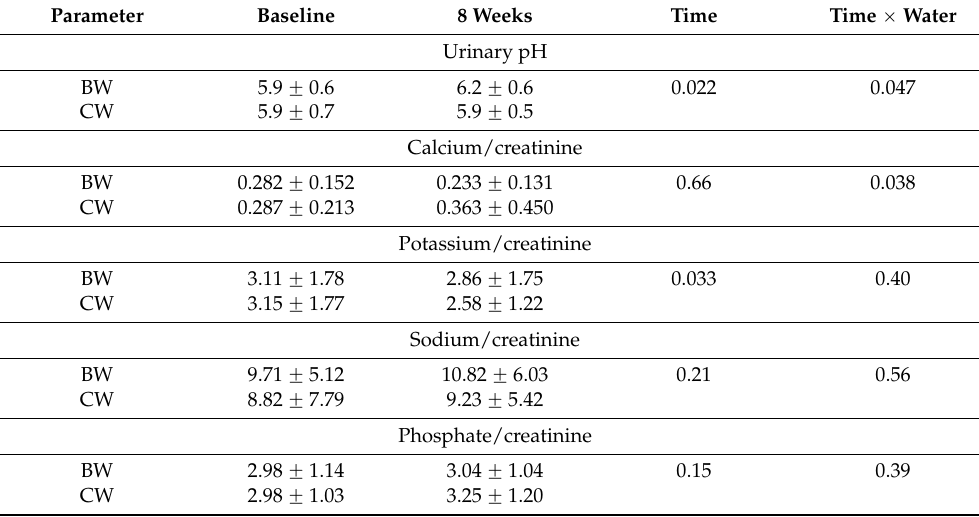
Table 5. Changes in urinary pH and mineral excretion of volunteers consuming bicarbonated water (BW) or control water